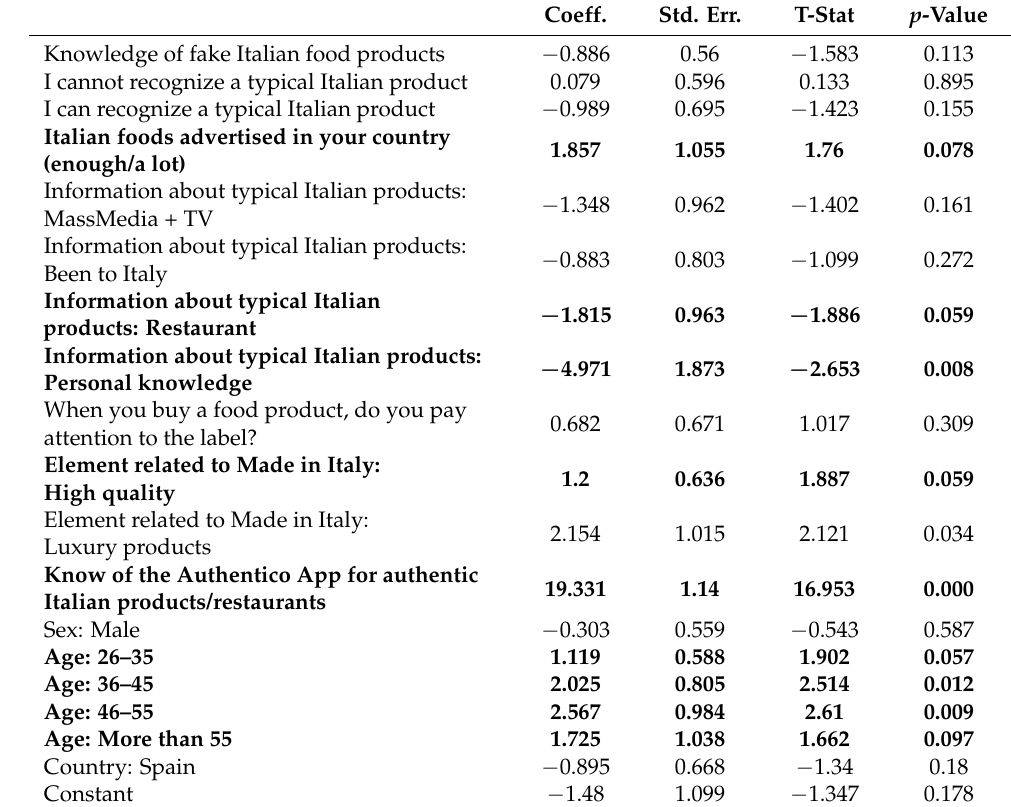
Table 3. Binary probit model results.